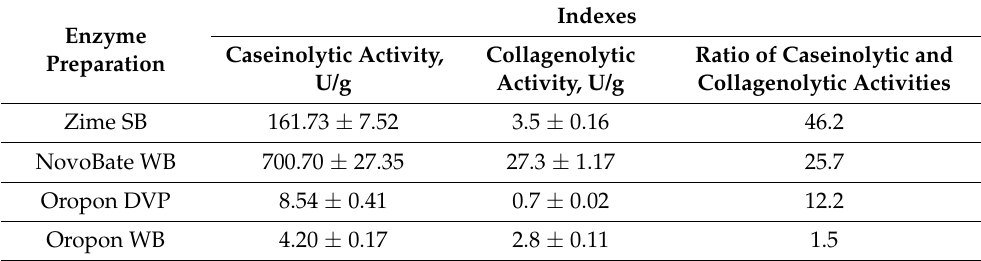
Table 2. Proteolytic activity at 40 ◦ C; 5.5 pH for caseinolytic and 5 pH for collagenolytic activity.